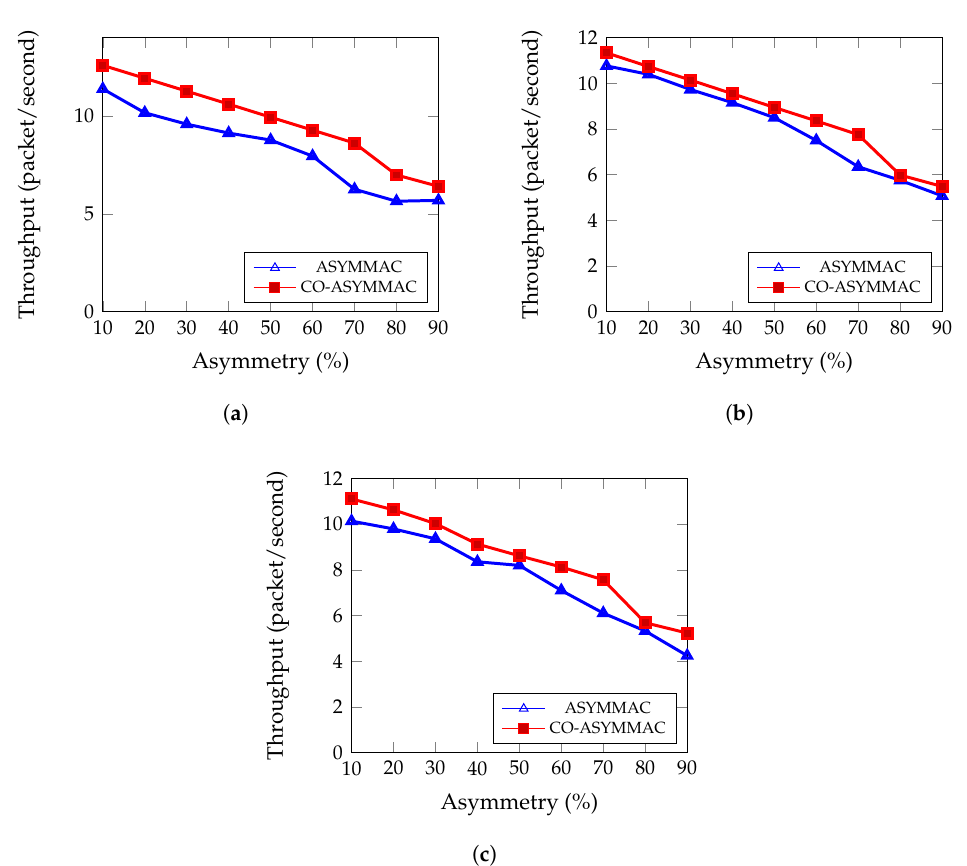
Figure 14. System Throughput: ( a ) for 27 nodes; ( b ) for 54 nodes; and ( c ) for 90